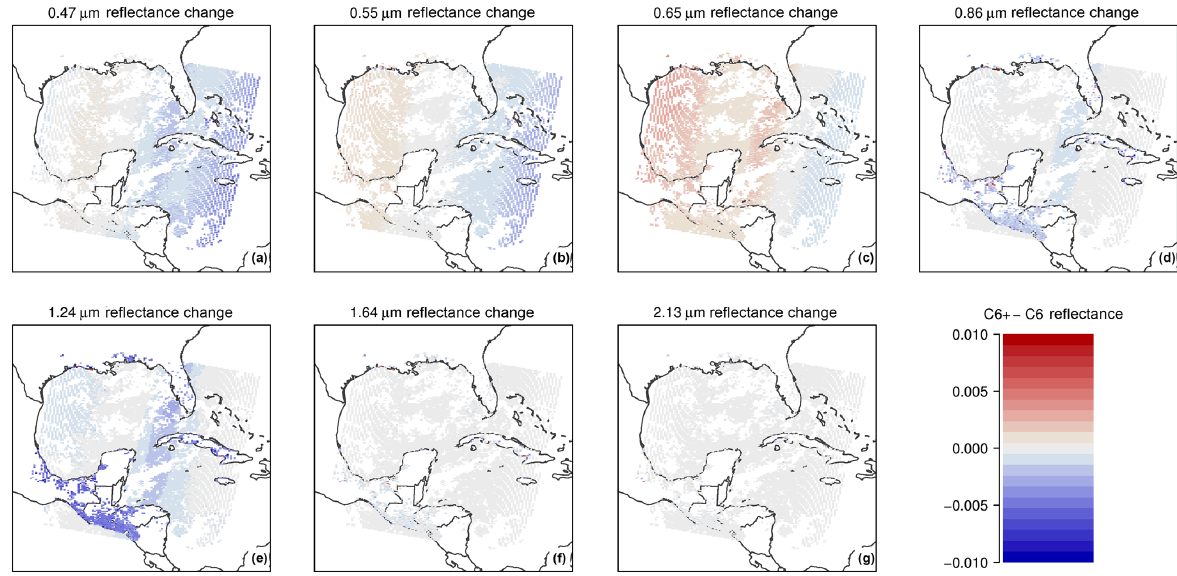
Figure 9. Impact of applying C6 + calibrations to MODIS-T reflectance data on 25 July 2008 at 16:25UTC. Absolute differences in each wavelength band.